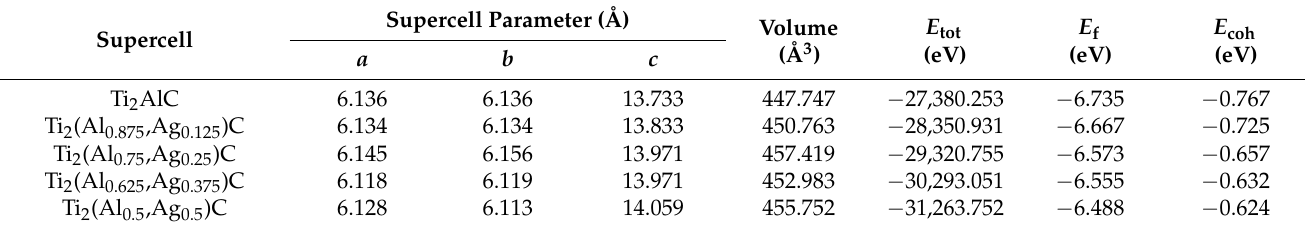
Table 1. Effect of substitution ratio of Ag for Al on lattice structure and stability of the Ti 2 (Al 1 − x ,Ag x )C supercells. Supercell Parameter (Å) Supercell